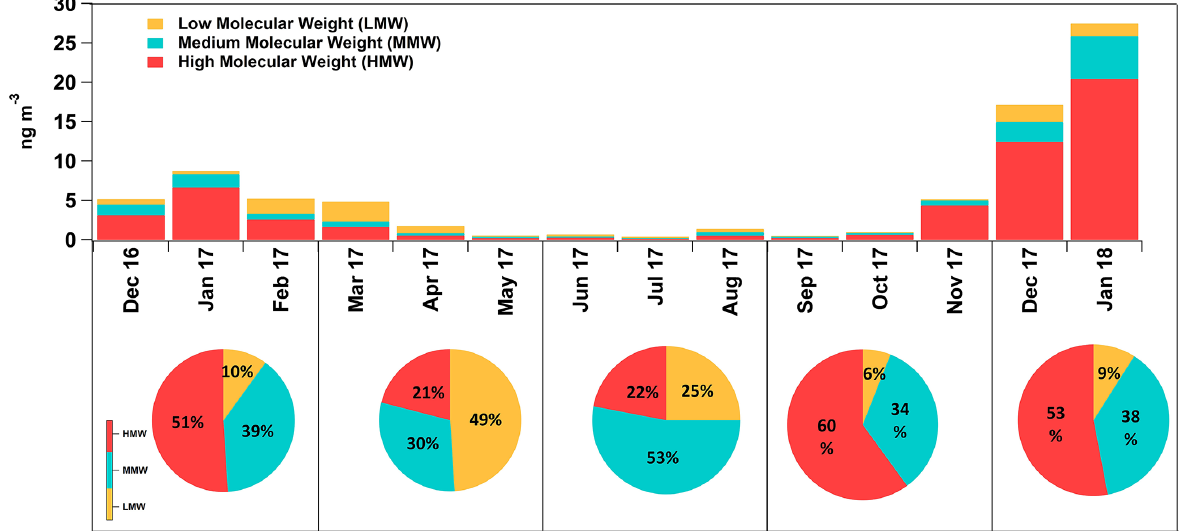
Figure 1. The color bars represent the mean monthly concentrations of high (HMW), medium (MHW), and low (LMW) molecular weight PAHs, between December 2016 and January 2018. The pie charts in the lower row show the concentration fractions of LMW, MMW, and HMW PAHs in each seasonin each season, starting with winter on the far left, moving to spring, then to summer in the middle, autumn, and lastly winter again on the far